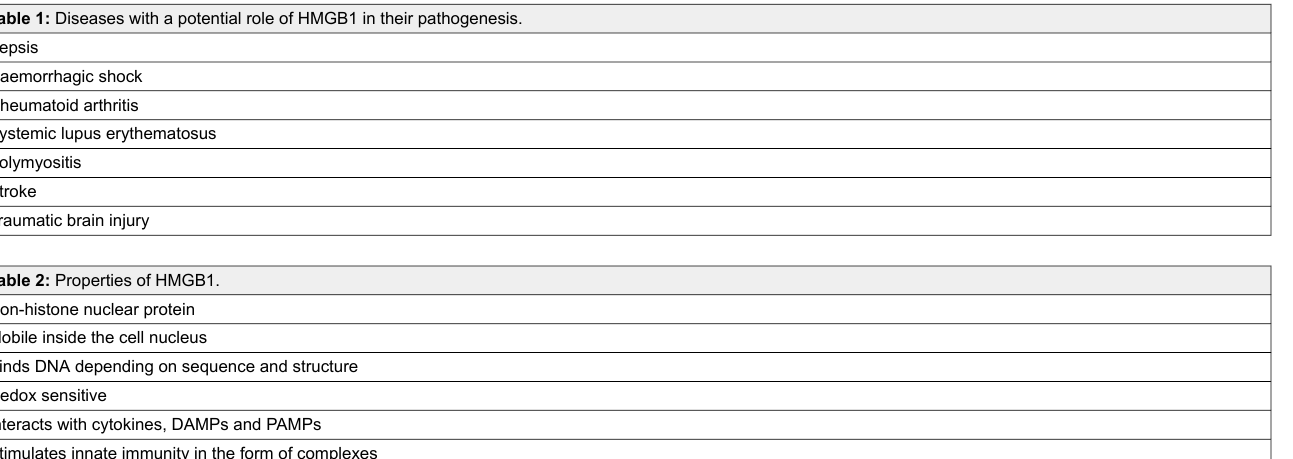
Table 2: Properties of HMGB1. Non-histone nuclear protein Mobile inside the cell nucleus Binds DNA depending on sequence and structure Redox sensitive Interacts with cytokines, DAMPs and PAMPs Stimulates innate immunity in the form of